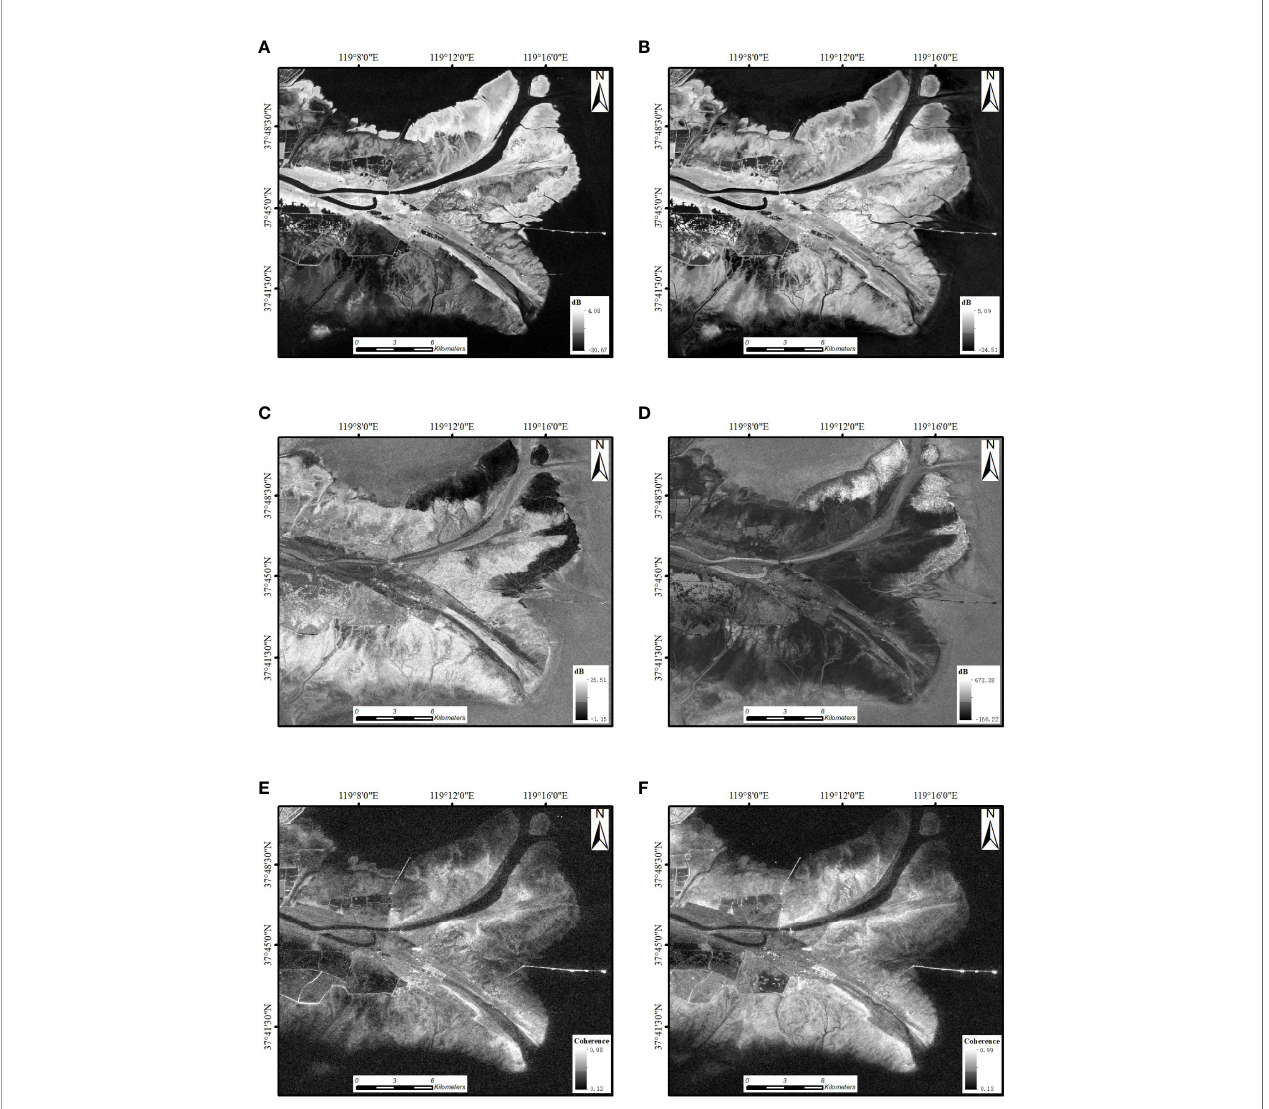
FIGURE 3 | Annual mean backscattering and coherence maps of the study area. (A) is the annual mean backscattering coef fi cient map under VH polarization; (B) is the annual mean backscattering coef fi cient map under VV polarization; (C) is the SAR sub map according to the formula (2); (D) is the SAR div map according to the formula (3); (E) is the annual mean coherence coef fi cient map under VH polarization; and (F) is the annual mean coherence coef fi cient map under VV polarization. All legends are marked in the lower right corner of the fi